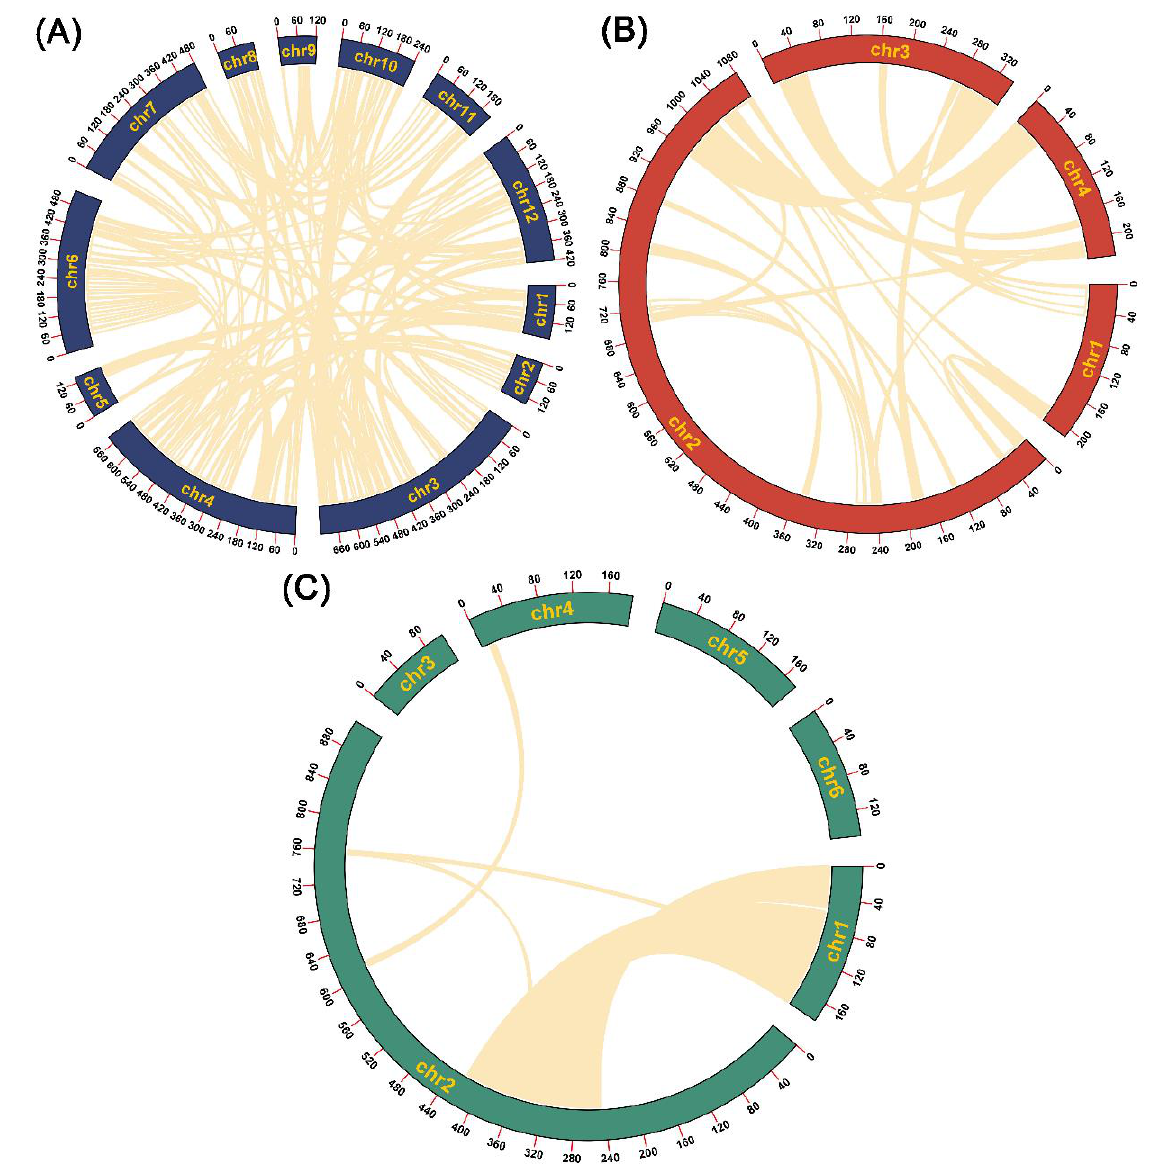
Figure 3. The mitogenomic-segment-duplication distributions of the 3 Cistanche species. ( A ) Cistanche tubulosa . ( B ) Cistanche deserticola . ( C ) Cistanche salsa . The outermost circle marks the position of the mitogenome. The bright yellow arcs indicate segment duplication.